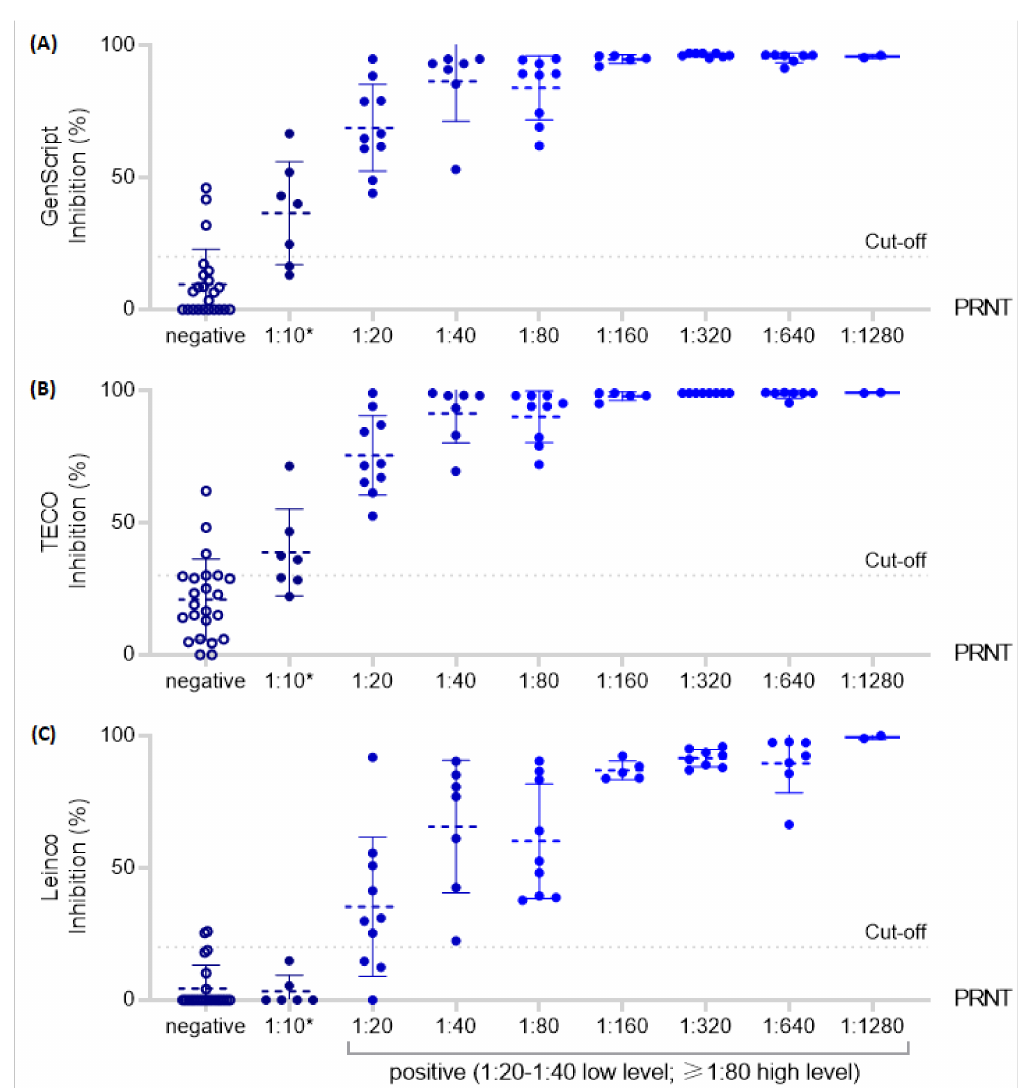
Figure 4. Distribution of the inhibition (%) of each examined sELISA in relation to the PRNT conducted in parallel, including mean and standard deviation bars. PRNT test results ≥ 1:10 (“borderline” or positive results) are shown as filled data point symbols and negative results are shown as empty data point symbols. Error bars outside the axis limits are not shown. ( A ) = GenScript; ( B ) = TECO; ( C ) = Leinco assay; * “borderline”